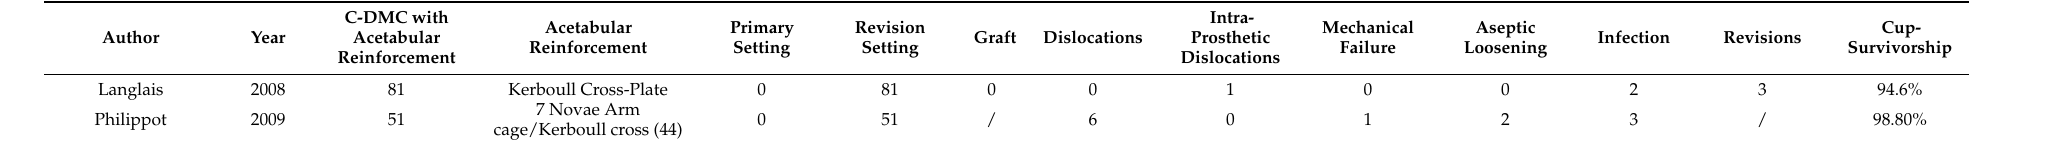
Table 9. Cemented DMC with acetabular